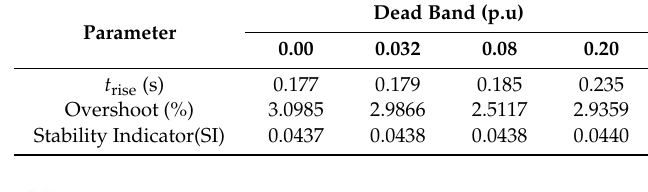
Figure 12. Voltage profile due to large disturbance. Table 4. Performance indicators result according to dead band range.